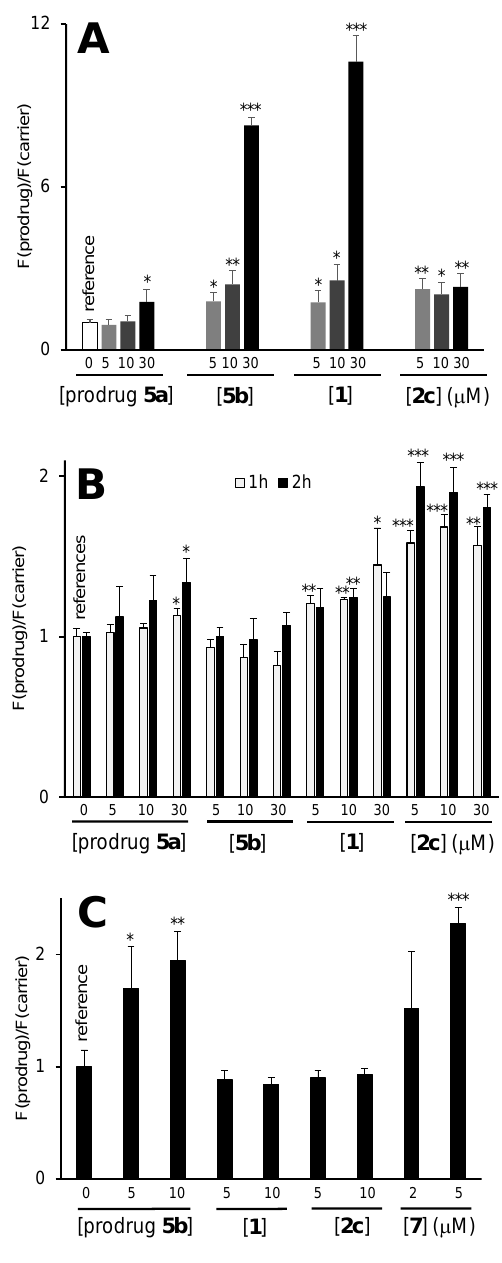
Figure 4. ( A ) Effects of prodrugs on the intracellular total ROS amount (tROS) in A2780 cells. F(prodrug)/F(carrier): the increase of the mean fluorescence ( λ ex = 488 nm, λ em = 525 nm) of (CM- DCFH-DA)-loaded A2780 cells incubated with the prodrugs relative to that of the cells incubated with the carrier only (labelled “carrier”). The “carrier” sample was used as a reference. ( B ) Effects of prodrugs on the intracellular amount of mitochondrial ROS (mROS). F(prodrug)/F(carrier): the increase of the mean fluorescence ( λ ex = 488 nm, λ em = 578 nm) of the A2780 cells incubated with the prodrugs, as determined using MitoSOX, relative to that of cells incubated with the carrier only (instead of the prodrugs). ( C ) Monitoring intracellular carbonyl derivatives in A2780 cells. F(prodrug)/F(carrier): the increase of the mean fluorescence ( λ ex = 488 nm, λ em = 525 nm) in A2780 cells incubated with the prodrugs, as determined using DCCH, relative to that of the cells incubated with the carrier only (instead of the prodrugs). For ( A – C ). *: p < 0.05; **: p < 0.01; ***: p < 0.001 (Student’s t -test with respect to the “carrier” probe: indicated with “reference” on the